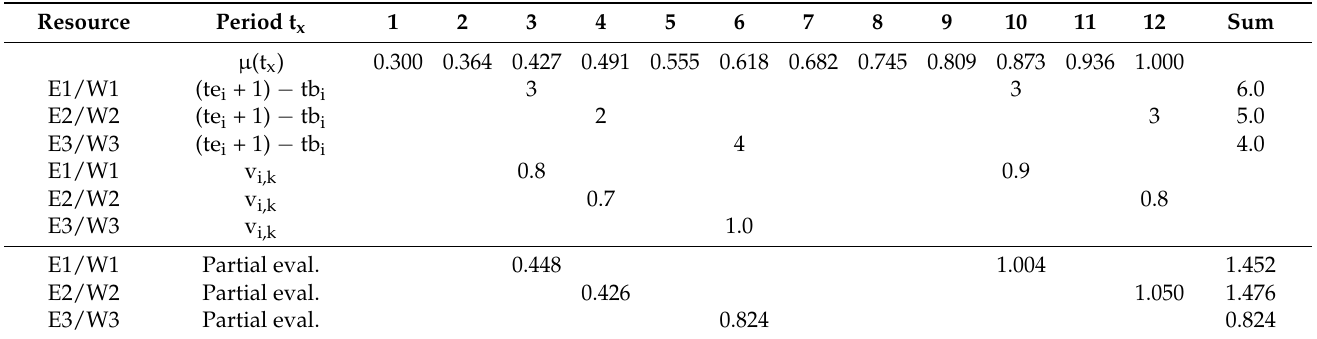
Table 2. An example of calculating the value of a single competency of employee W of enterprise E.